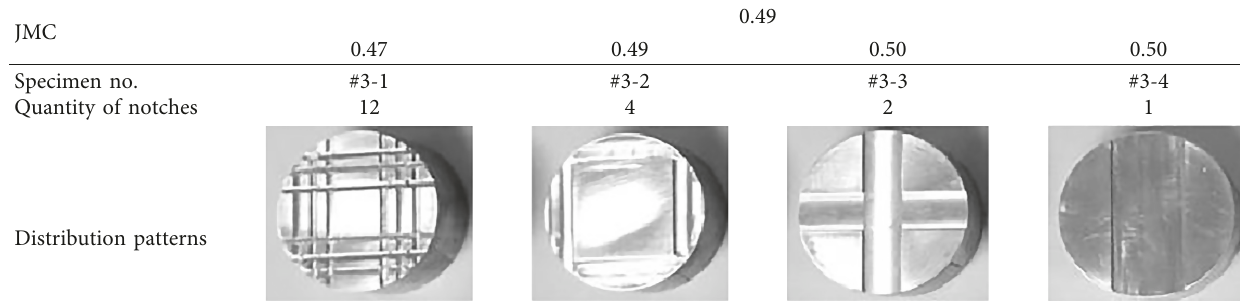
Table 4: Geometrical parameters of the specimens: #Set